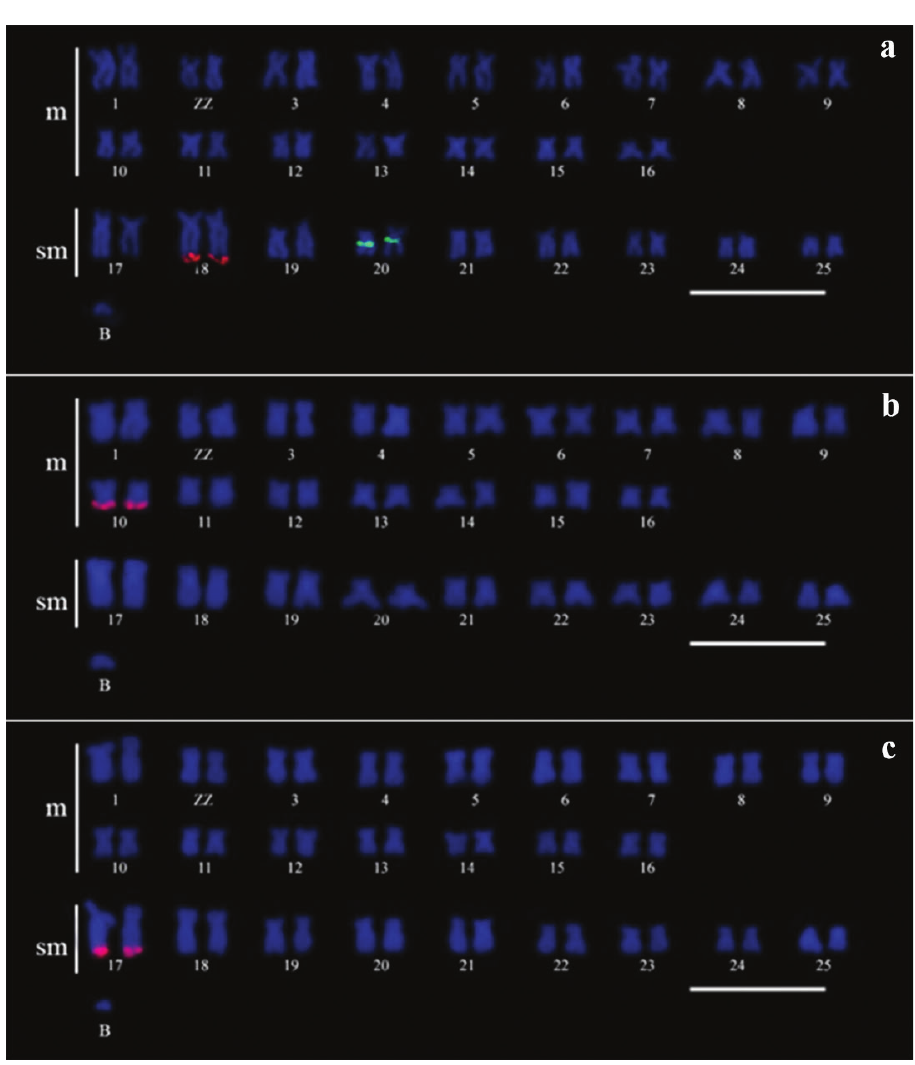
Figure 4. Karyotypes of Characidium alipioi arranged from mitotic metaphases after FISH with repetitive DNA probes. a 18S and 5S rDNA probes b histone H3 probe, and c U2 snRNA probe. Bar =10